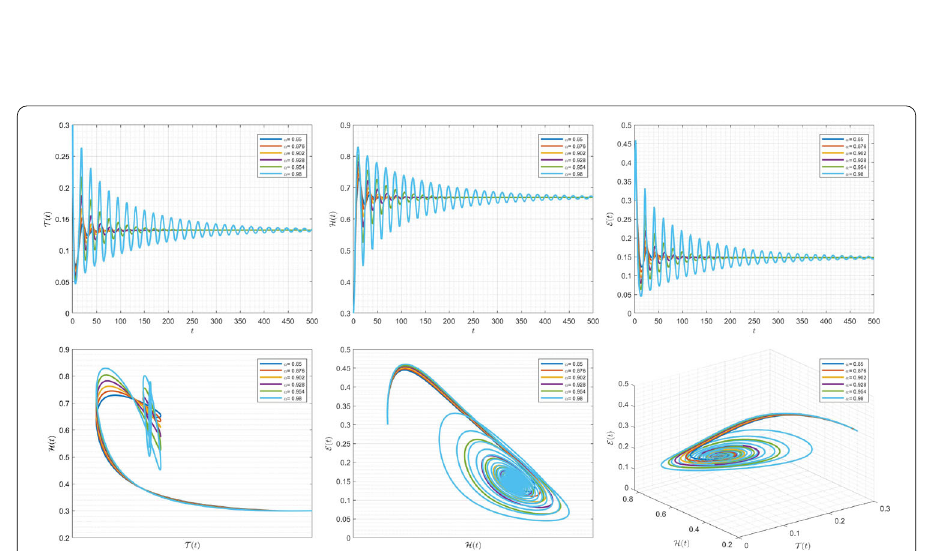
Figure 2 Simulations for solving (7) using (26) along with ( T (0), H (0), E (0)) = (0.3,0.3,0.3) and β 12 =